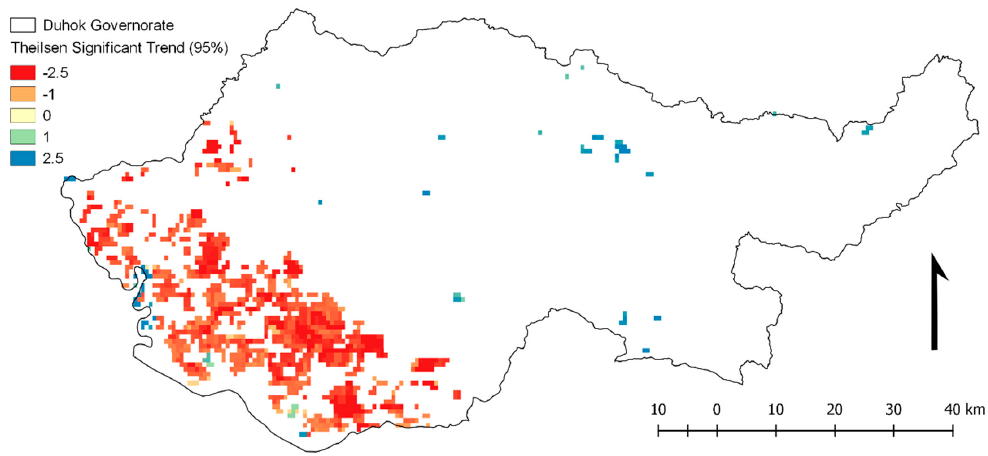
Figure 5. Growing season productivity trend represented by the trend slope, i.e., the gain or loss of net photosynthesis (PSN, gCm − 2 ) per year. Only statistically significant ( p < 0.05) areas are shown.